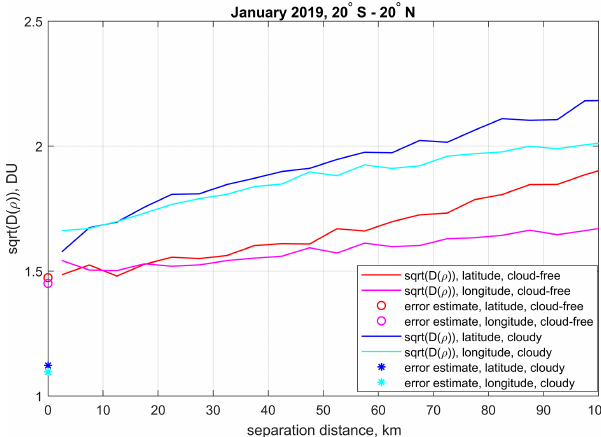
Figure 7. One-dimensional structure functions in latitude and in longitude separations (color lines), which are computed from a two-dimensional structure function like in Fig. 4 by averaging over longitude–latitude separations from 0 to 20km. The symbols at zero separations indicate ex ante uncertainty